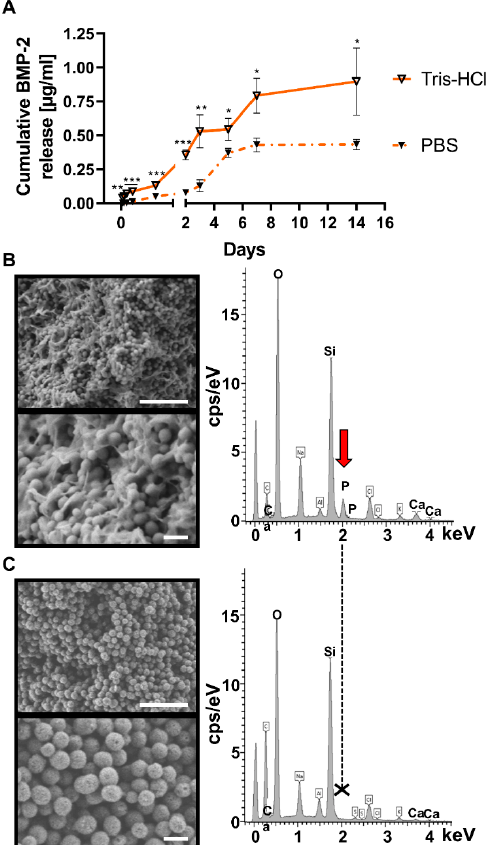
Figure 2. In vitro BMP-2 release experiment in PBS and tris-HCl quantified via an α -BMP-2 ELISA and analyzed SD-MBG at the end of the release experiment by FE-SEM and EDS. ( A ) BMP-2 cumulative release profile over 14 days for the in vivo applied SD-MBG + BMP-2 dosage (0.75 mg SD-MBG, 50 µg BMP-2), supernatants from SD-MBG + BMP-2, immersed in either PBS or tris-HCl were sampled and used for BMP-2 quantification. n = three independent samples, tested at least in duplicates in the ELISA. A two-tailed Student’s t -test was performed to compare the cumulative amount of detected BMP-2 between elution in PBS and tris-HCl at each time point. ( B + C ) FE-SEM images (left) and EDS spectra (right) of particles after the release experiment, ( B ) in PBS, ( C ) tris-HCl. The red arrow points at the phosphate peak, which is only present for the PBS-soaked SD-MBG. Top image of ( B , C ) scale bar = 1 µm, bottom image scale bar = 200 nm. PBS: phosphate buffered saline, α -BMP-2: anti-bone morphogenetic protein-2, ELISA: enzyme-linked immunosorbent assay, FE-SEM: field-emission scanning electron microscopy, EDS: energy-dispersive X-ray spectroscopy. p -values for statistical significance were * p < 0.05, ** p < 0.01, *** p < 0.001.